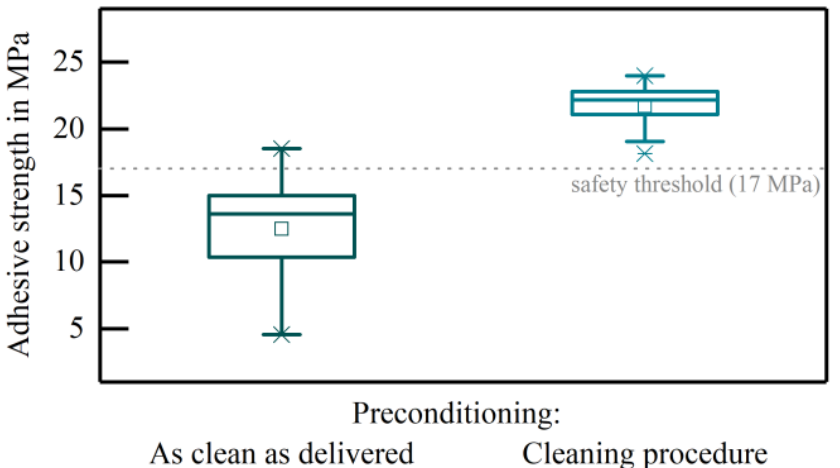
Figure 1. Adhesive strength of PtAu metallisation layers on Al 2 O 3 substrates without (n = 17) and with a treatment with the cleaning procedure (n = 10) prior to screen-printing.